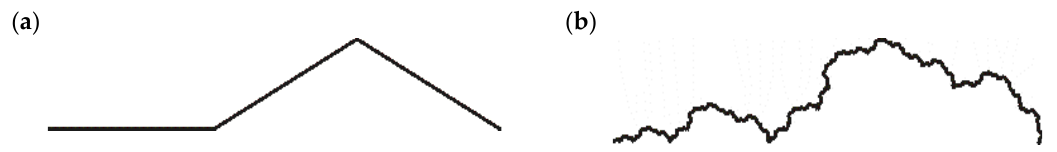
Figure 7. Generator shape used in the papers [45,46].